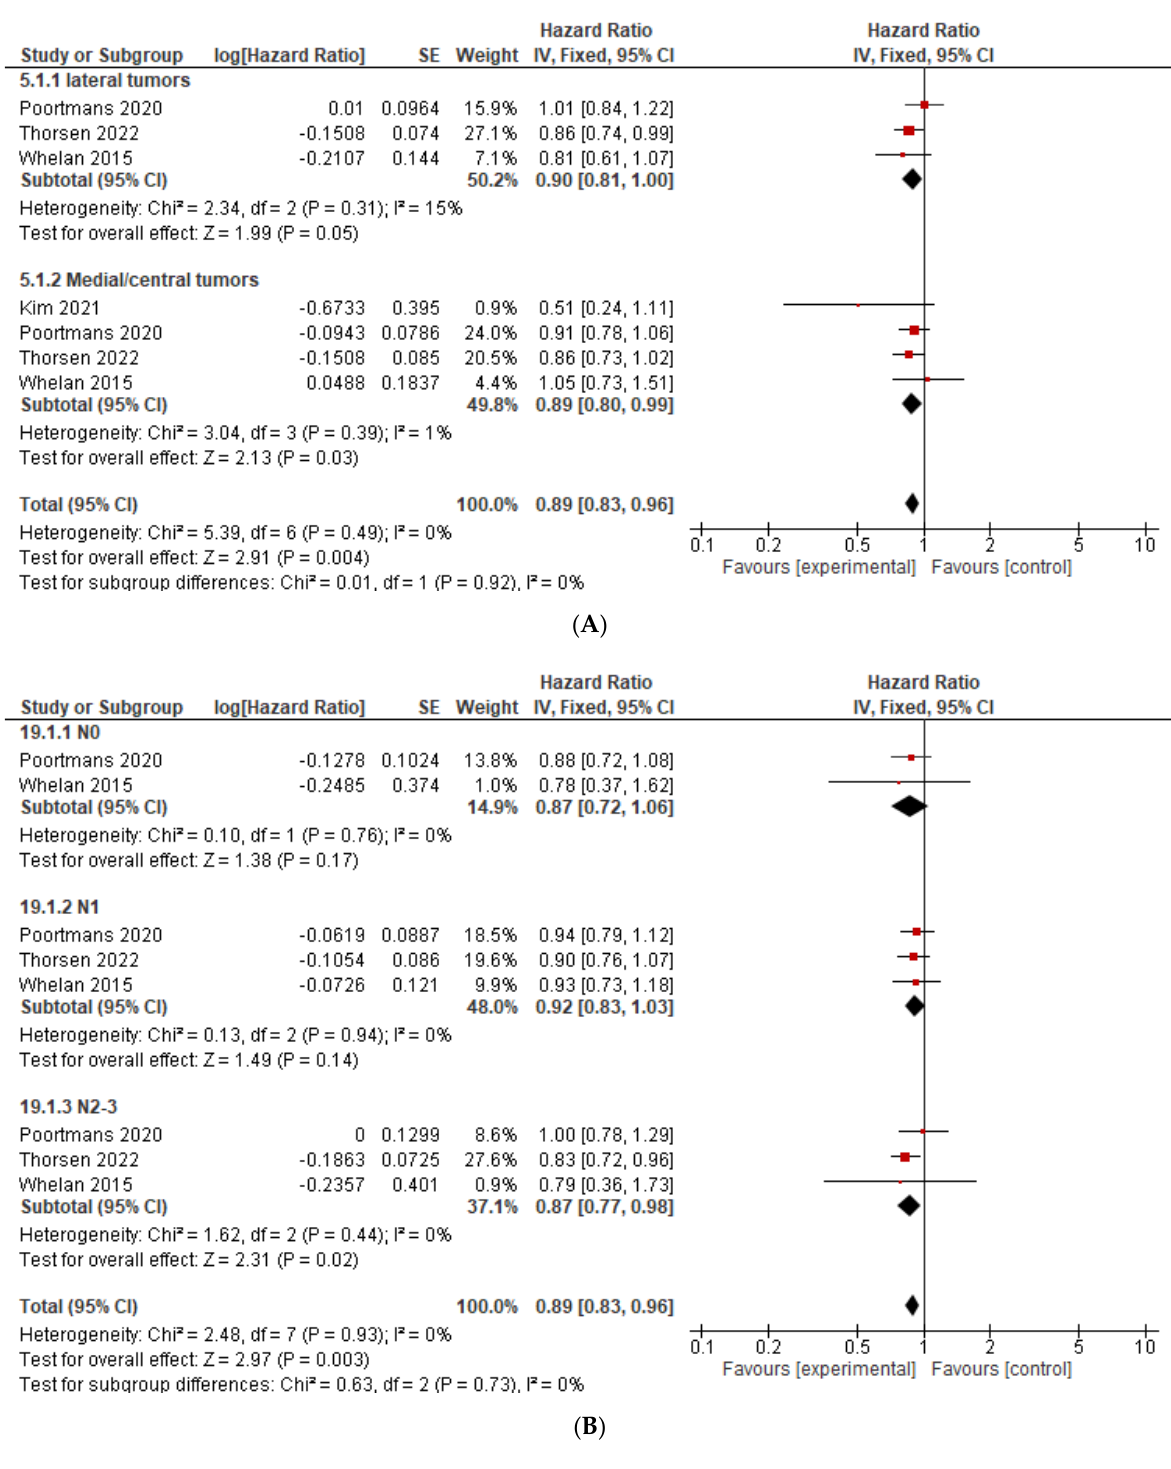
Figure 4. Forest plots for OS by subgroups, hazard ratio for: ( A ) OS by tumor location (medial/central compared to lateral); ( B ) OS by nodal involvement. The weight of each trial in the meta-analysis is represented by the size of the squares. The estimated pooled effect is represented by a diamond shape. p values are two-sided. References: Hennequin 2013 [13], Kim et al., 2021 [24], Poortmans